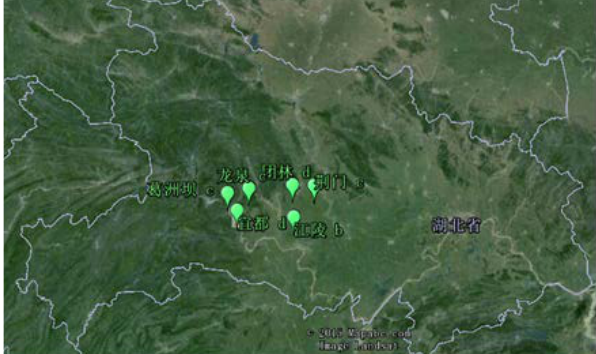
Figure 6 Location of field survey points.